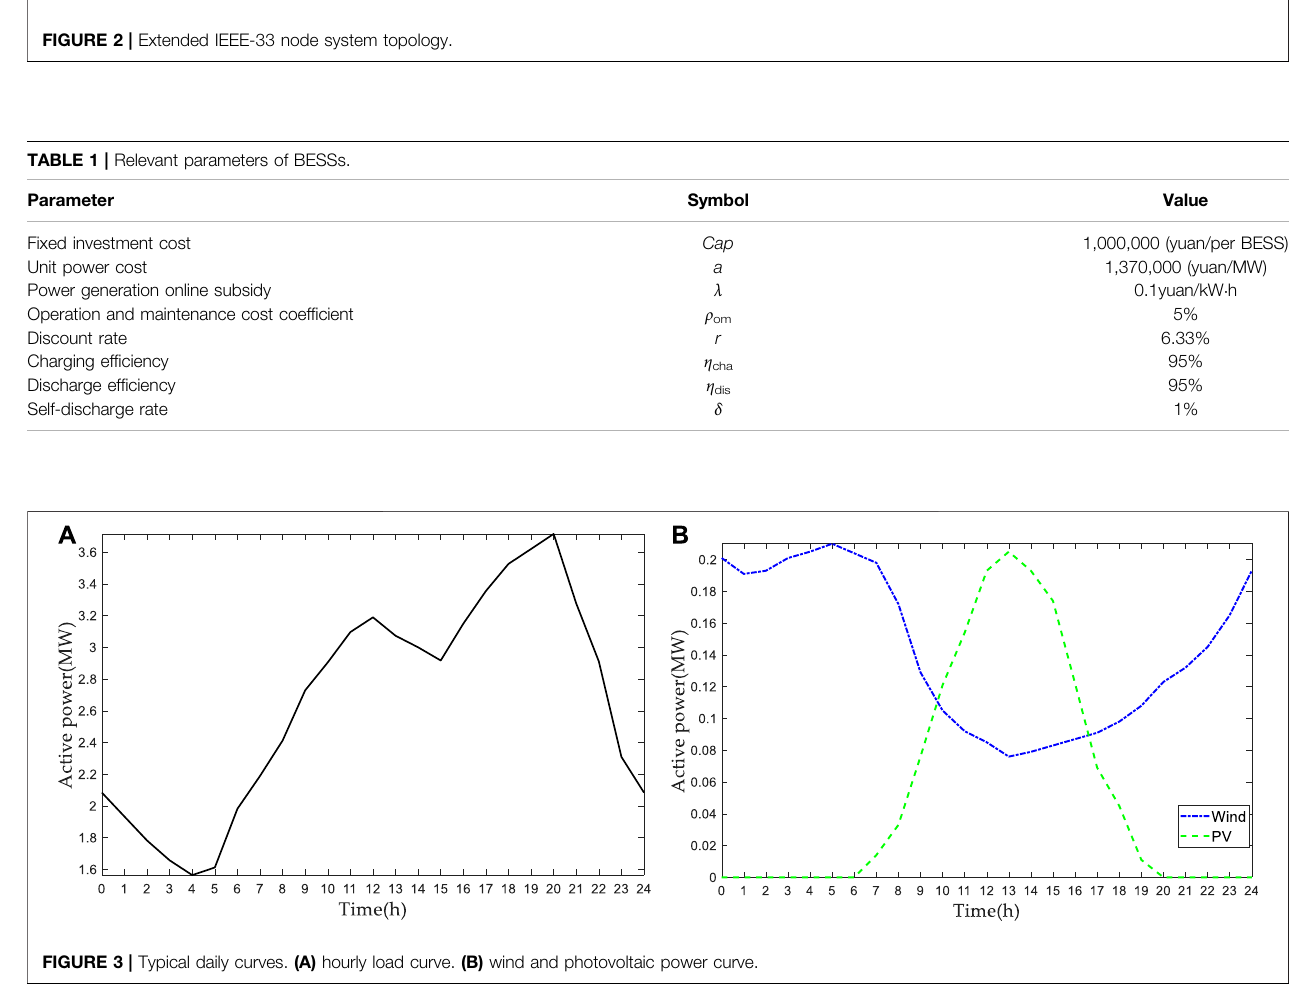
Frontiers in Energy Research |